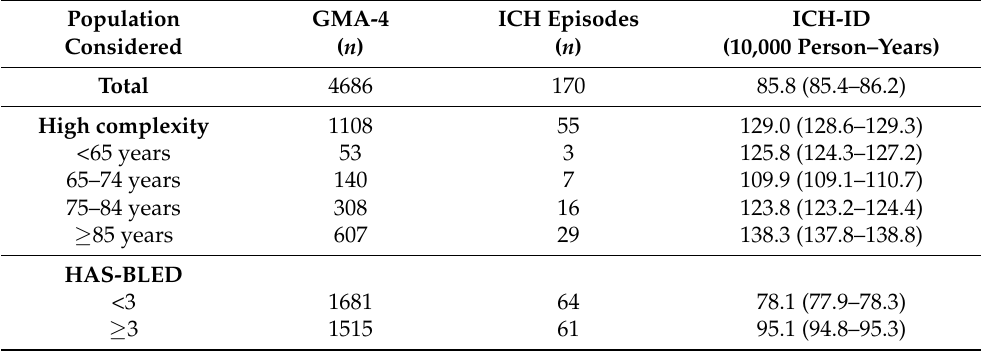
Table 4. ICH incidence density by age groups in the high-complexity GMA-4 population and by HAS-BLED